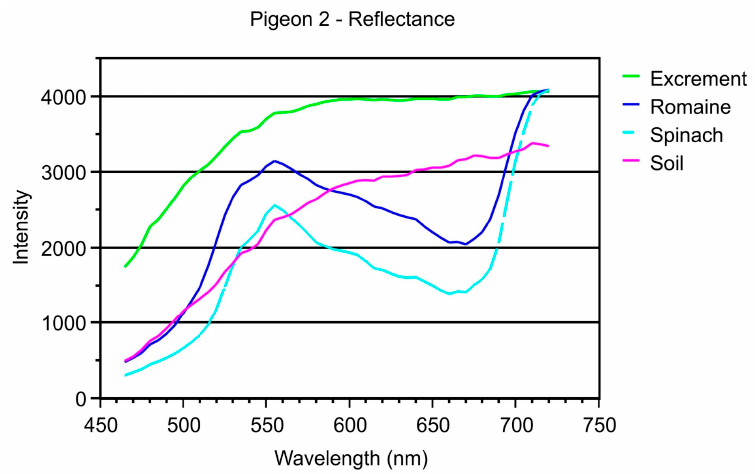
Figure 6. Reflectance spectra for a dove dropping, romaine leaf, spinach leaf, and soil.